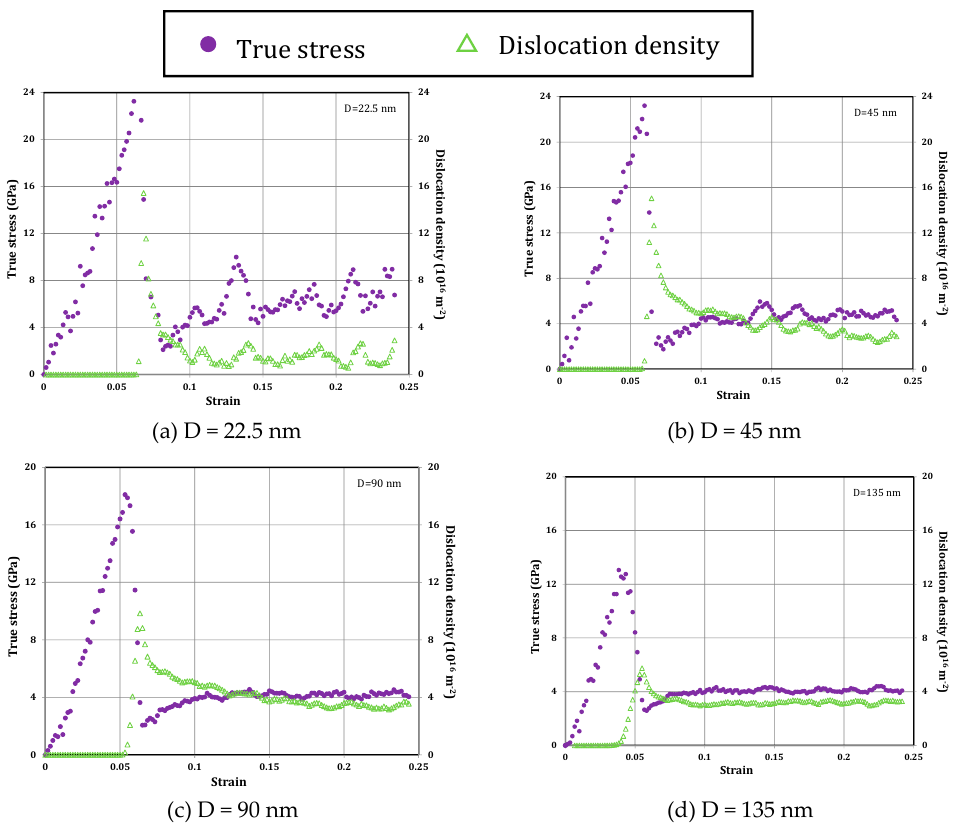
Figure 15. The responses of samples during micropillar compression test in the cases of pillars with H = 45 nm and different diameters of: ( a ) D = 22.5 nm; ( b ) D = 45 nm; ( c ) D = 90 nm; ( d ) D = 135 nm (after Yaghoobi and Voyiadjis and [21]).